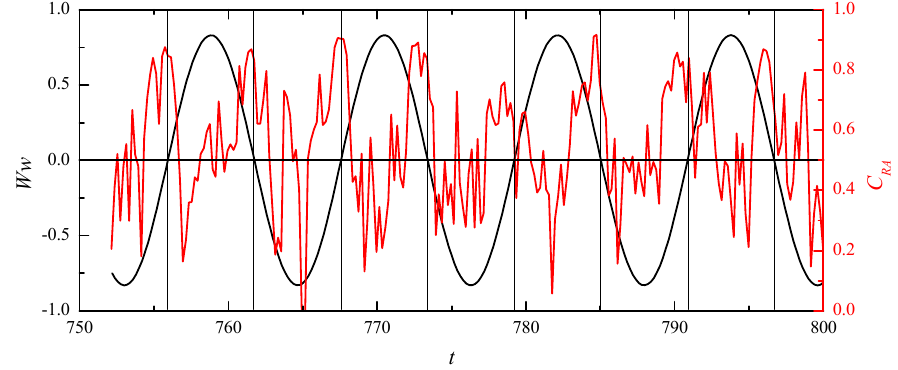
Figure 18. Temporal evolution of C RA for Case P150A20. Table 3. Mean values of skin friction, Stanton number and their correlation.